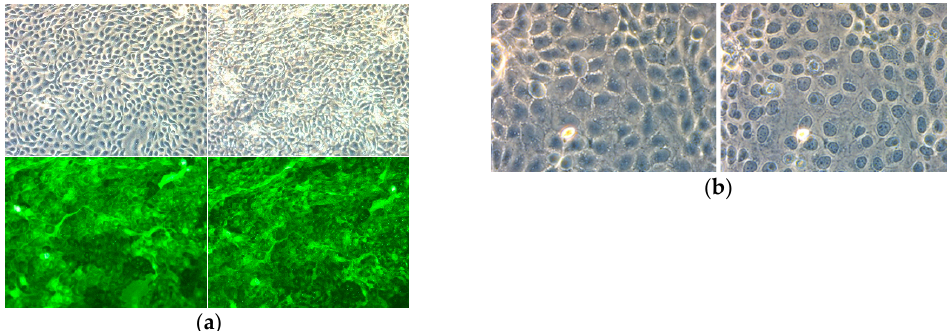
Figure 8. Change in cell shape ( a ) with heat treatment ( × 20) and ( b ) with dimethylsulfoxide (DMSO) treatment ( × 63) before (left) and after (right), phase contrast (top) and fluorescence (bottom)